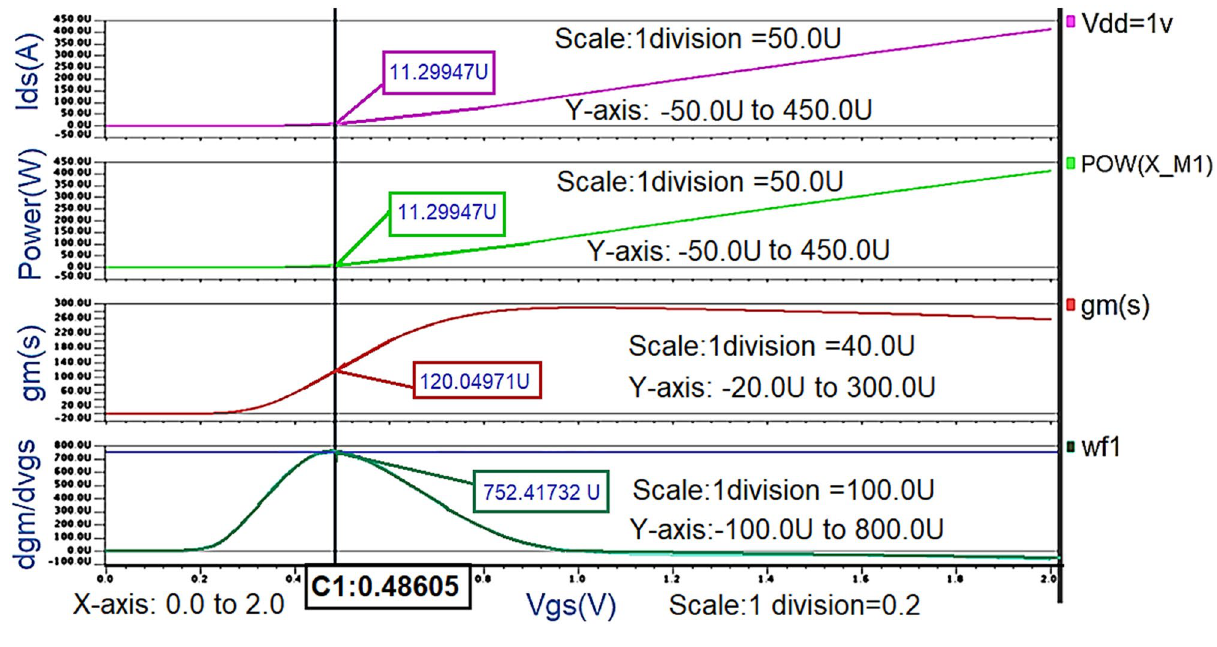
Figure 5. V th of nm_hp model NMOS